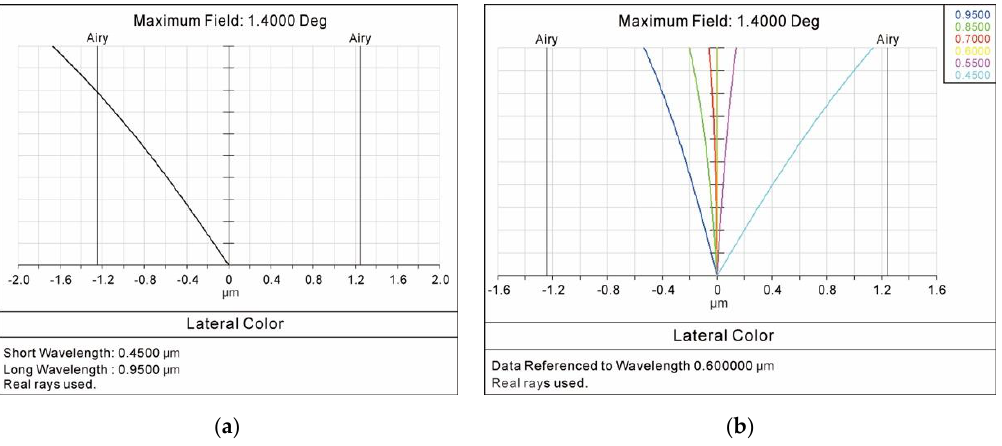
Figure 6. Lateral color curves ( a ) between the short wavelength of 450 nm and the long wavelength of 950 nm, ( b ) between different wavelengths (450–950 nm) and the center wavelength of 600 nm.